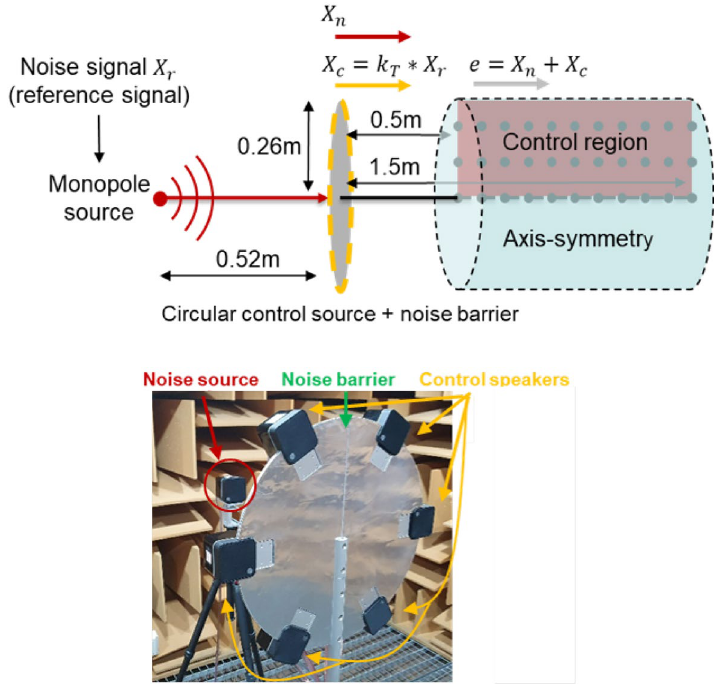
Figure 8. Configuration of the experimental system (top) and the constructed experimental system in an anechoic chamber (bottom).